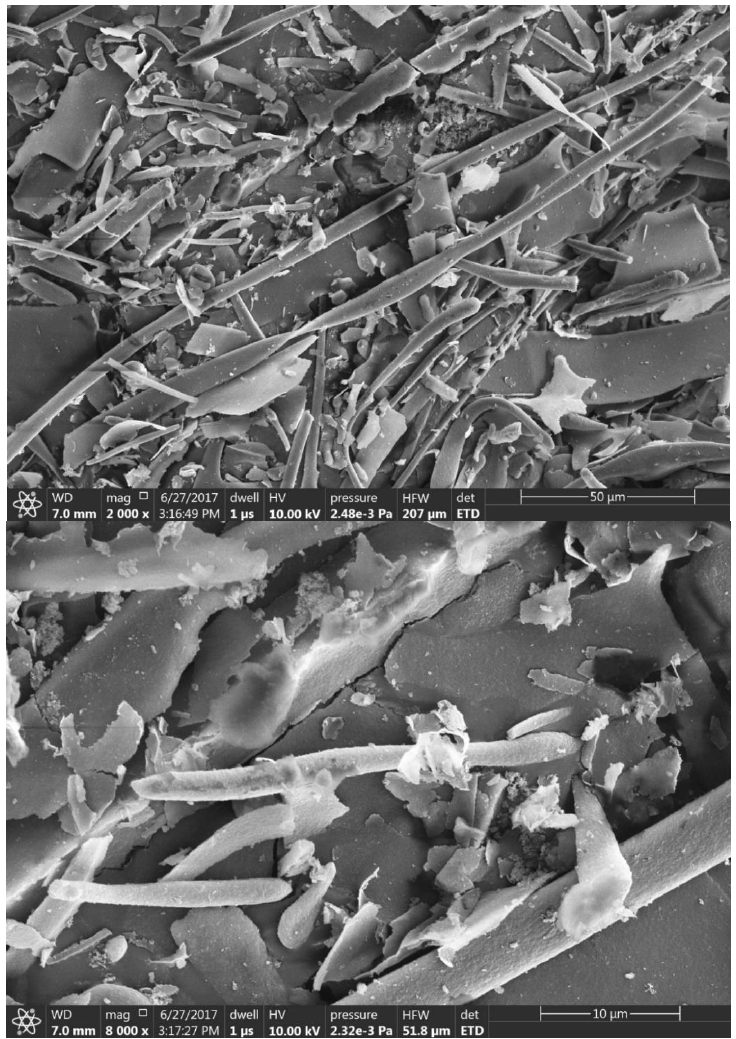
Figure 1. SEM images of CMC powder.